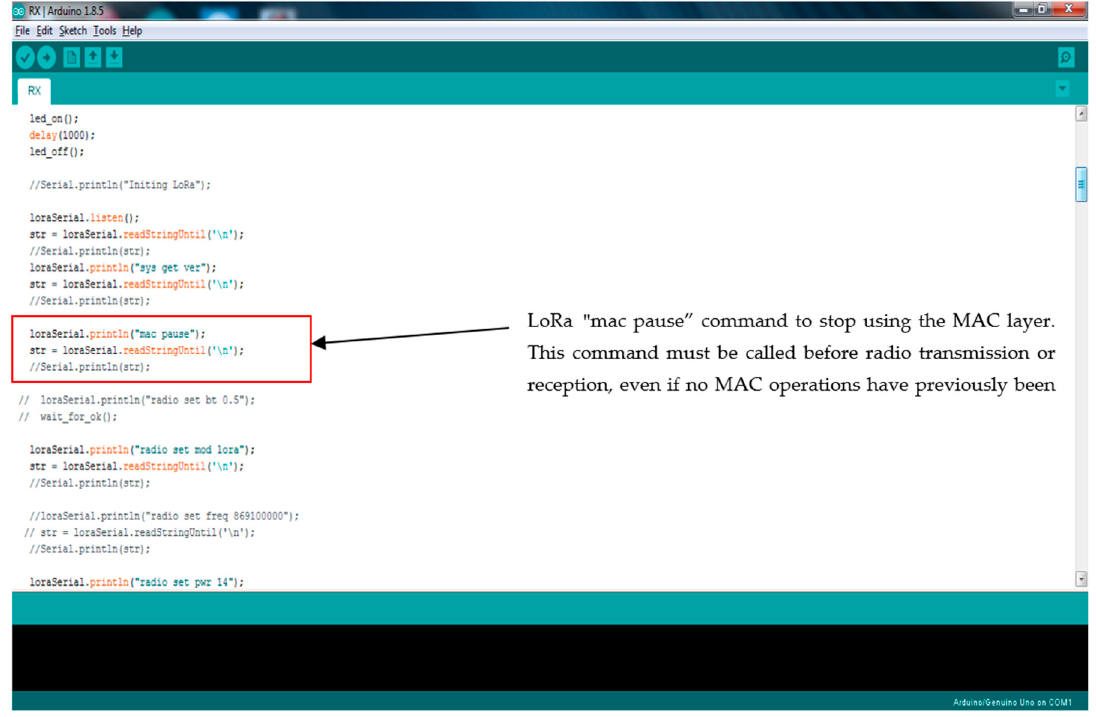
Figure A1. The “MAC pause” command used to stop data encryption over the MAC Layer.